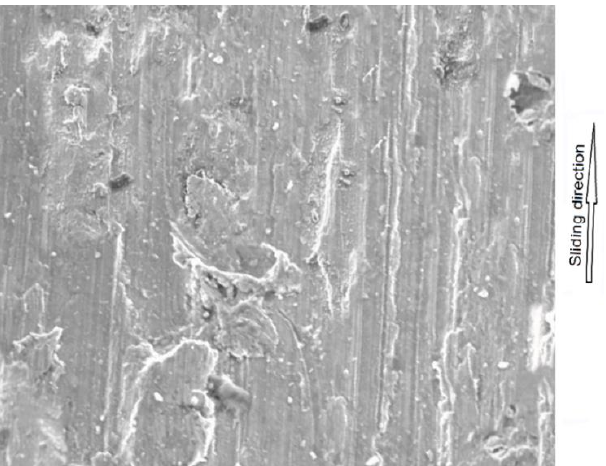
Figure 12. SEM micrograph of one of the back plate sample friction path. After conducting the tests on the T-11 station, each sample was washed, dried and weighed. Each set of samples cut from the same brake pad was assessed in terms of the mass lost from before the test. Arithmetic average values (z av ) and standard deviations of the measurements were given by: